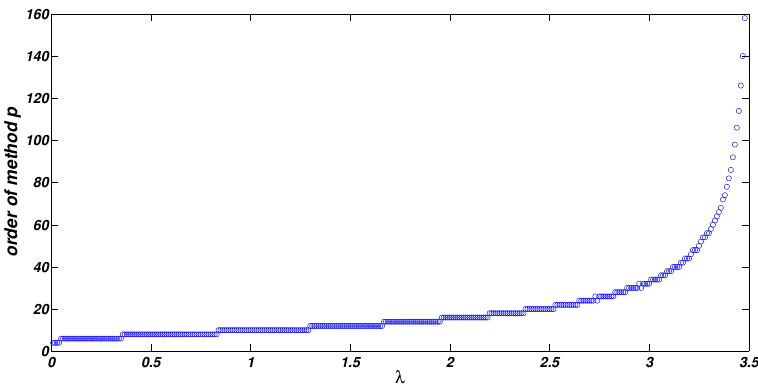
Figure 3. Order of the (2 r + 4) th HM family for each λ